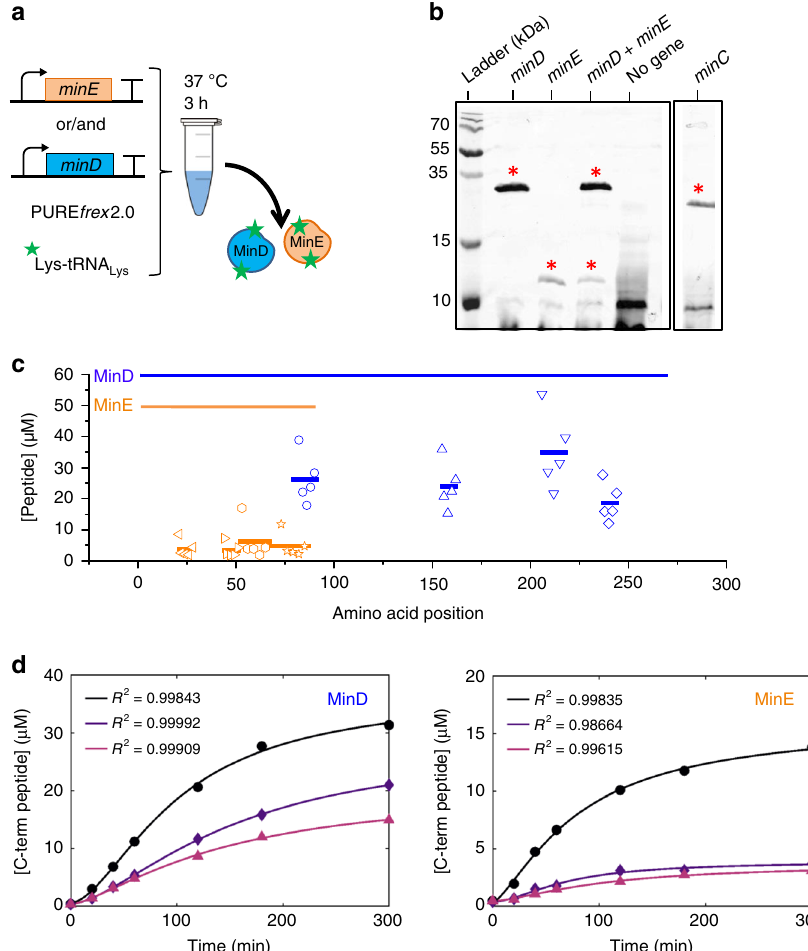
Fig. 1 Quanti fi cation of cell-free gene-expressed MinE and MinD proteins. a Schematic of co-translational labeling of MinD and MinE proteins in the PURE system. tRNA Lys preloaded with a BODIPY-conjugated lysine (GreenLys) is supplemented in a PURE frex 2.0 reaction. Same strategy was applied with MinC. b Translation products were analyzed by fl uorescence imaging of a 18% polyacrylamide gel. The bands depicted with an upper red star correspond to the full-length protein with expected molecular weight. In a control experiment with no genes added, a smear background of GreenLys is visible, which is distinct from the gene-speci fi c bands. c Quantitative LC-MS analysis of MinD and MinE proteolytic peptides and their position along the primary sequence of the proteins. The MinD- and MinE-annotated lines depict the full-length sequences. The amino acid sequence of the different peptides is reported in Supplementary Table 2. Peptide concentrations represent averaged values (displayed as segments whose length matches with the length of the corresponding peptide) over fi ve biological repeats (markers represent individual measurements), of which two included three technical replicates. d Concentration of the most C-terminal peptide of MinD (AYADTVER) and of MinE (DGDISILELNVTLPEAEELK) as a function of the expression time course. Symbols represent data from three independent experiments. The solid lines are fi ts to a mathematical model for gene expression (Equation (1)). Source data are provided as a Source Data fi